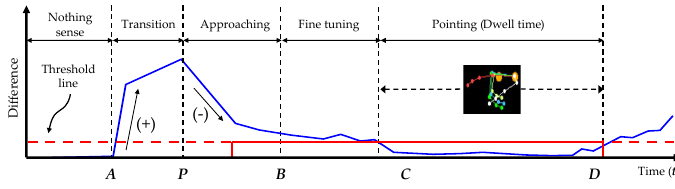
Figure 19. Thresholding for finding pause as pointing